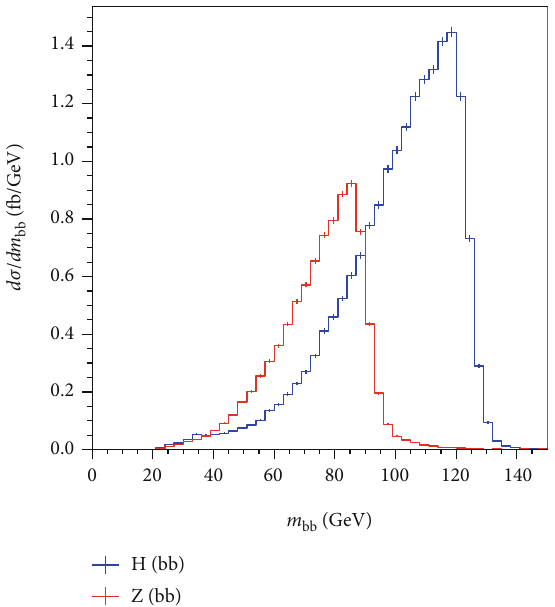
Figure 3: The η distributions of the leading and subleading b-jet from Higgs and Z boson decay. The electron-beam (100GeV) and muon-beam (3000GeV) come from the negative and positive η partition. The detector simulation is implemented through Delphes using the muon detector con fi guration. The Valencia algorithm [37] is used for jet reconstruction with the jet cone size as 0.5. The b-jets are required with p T > 20 GeV and ∣ η ∣ <2 : 5 , with the b-tagging e ffi ciency 70%. The η distributions indicate that jets are boosted towards the electron-beam side.